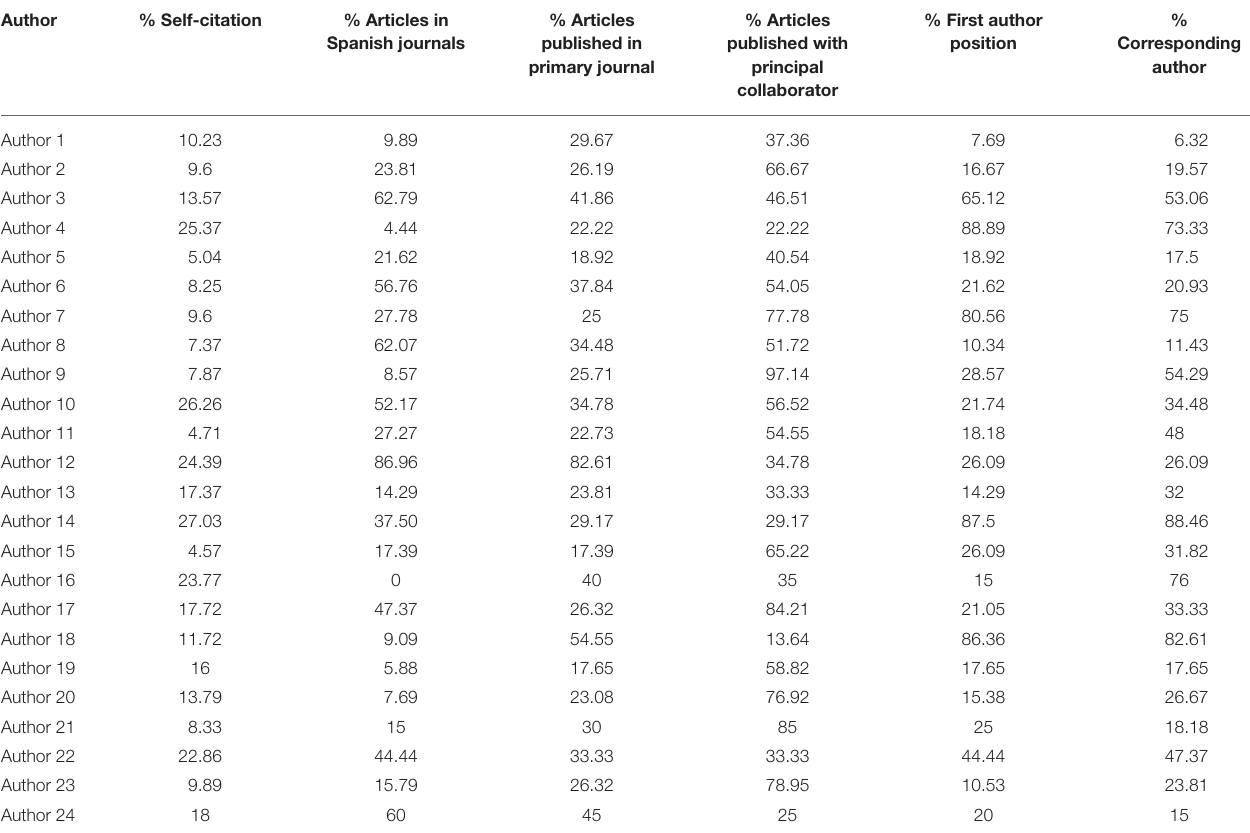
TABLE 2 | Control indicators for top-producing Spanish authors in the Web of Science category “Information Science and Library Science”